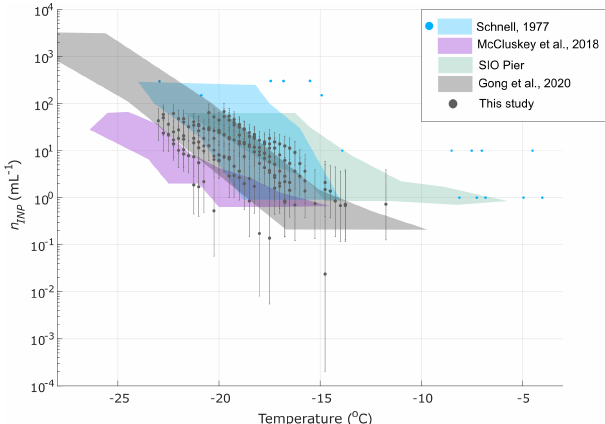
Figure 2. Measured n INP in 10 SSW samples collected during AQABA. Also shown are the composite INP spectra of 14 coastal SSW samples collected on São Vicente Island, Cabo Verde (Gong et al., 2020b), 17 coastal SSW samples collected at the Ellen Brown- ing Scripps Pier (green shading) and 12 SSW samples collected in the Southern Ocean (McCluskey et al., 2018d). Schnell’s (1977) SSW measurements are represented as a composite spectrum of 24 samples (blue shaded region) and 5 additional spectra (blue mark- ers) from samples that exhibited higher freezing temperatures. All spectra presented are uncorrected for freezing point